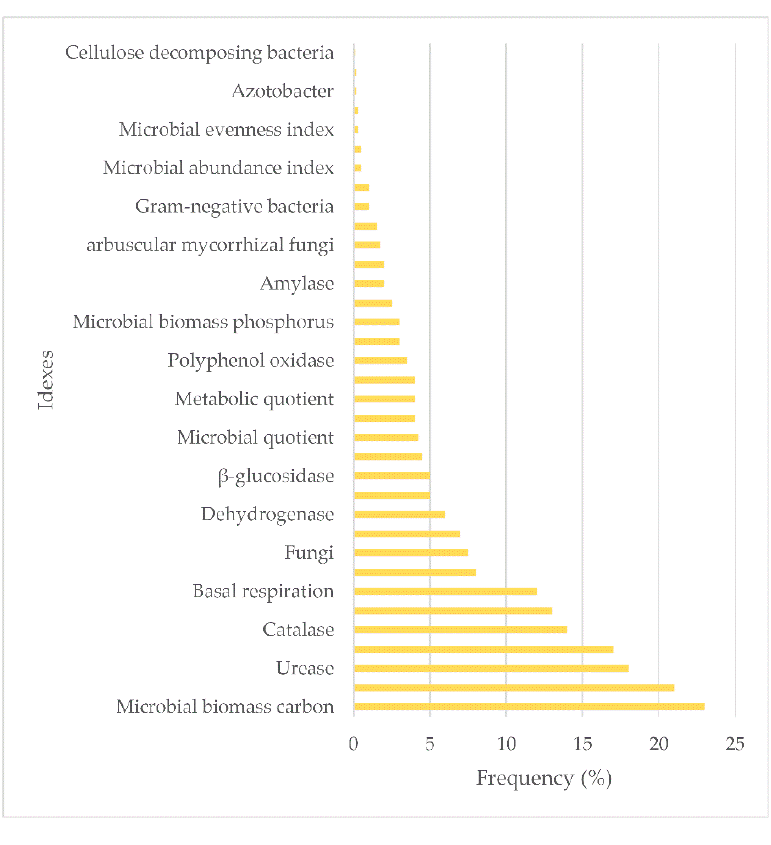
Figure 3. Soil biological evaluation indices.